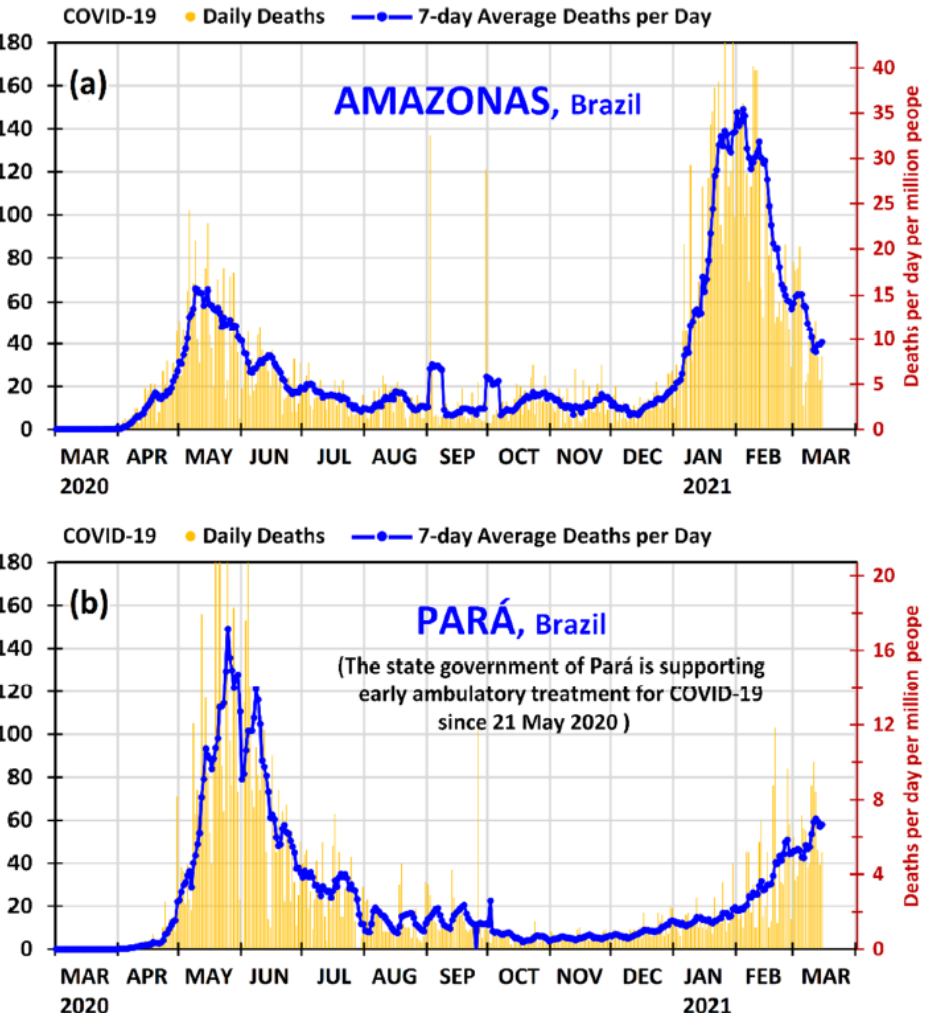
Figure 3. Daily deaths and 7-day average deaths per day of COVID-19 in the states of ( a ) Amazonas and ( b ) Par á in Brazil from 1 March 2020 to 15 March 2021. The deaths per day per million people can be found using the secondary vertical axis on the